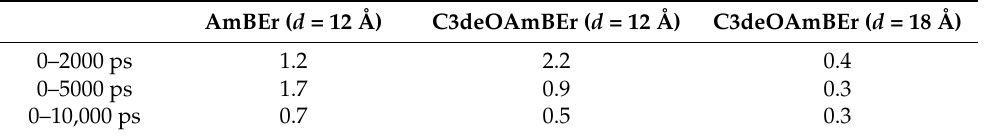
Table 2. Comparison of the calculated water permeability (10 − 11 mole m s − 1 m − 2 Pa − 1 ) for the three simulation channel models.